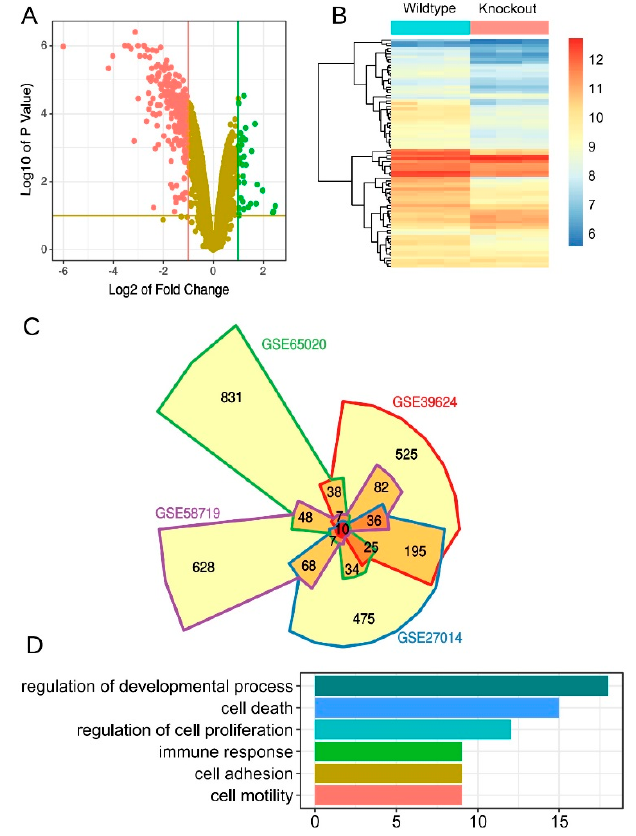
Figure 6. A consensus gene signature that is related to Klf5 knockdown. ( A ) Volcano plot showing genes with significant fold changes between Klf5 knockout versus Klf5 wild-type mouse samples in GSE39624 dataset; ( B ) heatmap showing the expression of an 84-gene signature in GSE39624 dataset; ( C ) top differentially expression genes from four independent datasets were compared and visualized by the Venn diagram; ( D ) gene ontology analysis of the 84-gene signature. Bars represented the number of genes mapped into each gene set.